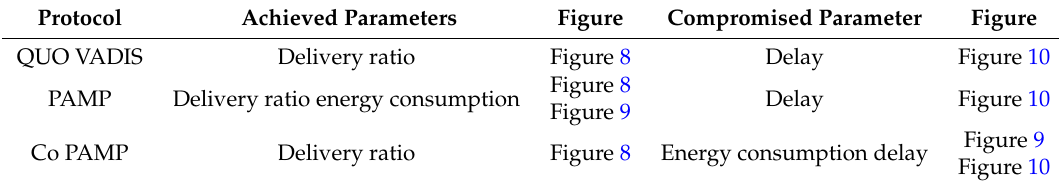
Table 5. Performance trade-offs in the proposed and compared